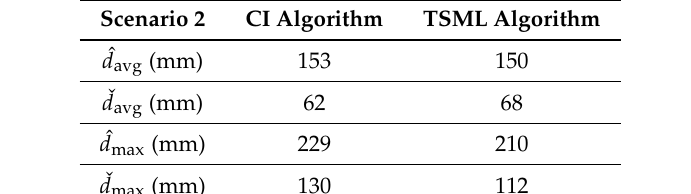
Table 3. The average and the maximum distance between the true TN position and its estimates with ( ˇ d avg , ˇ d max ) and without ( ˆ d avg , ˆ d max ) the use of the statistical model, when using the CI algorithm and the TSML algorithm, are shown.